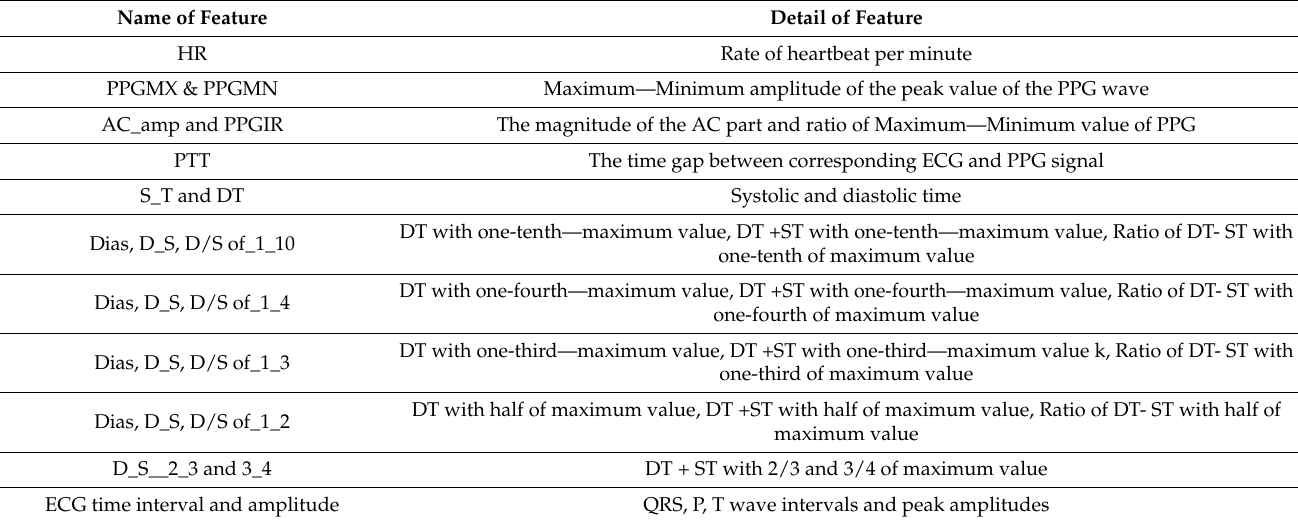
Table 1. The initial feature list from the feature extraction phase.